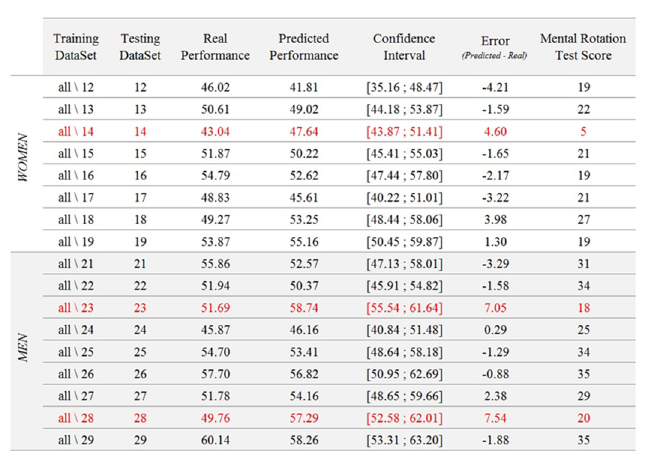
Fig 7. Results of the test of the 17 models generated from the training datasets on their respective testing datasets. The table shows training and testing datasets, the real performance of the testing dataset, the predicted performance of the testing dataset with the corresponding confidence interval, as well as the error of the model. Finally, in the last column the mental rotation score of the participant is